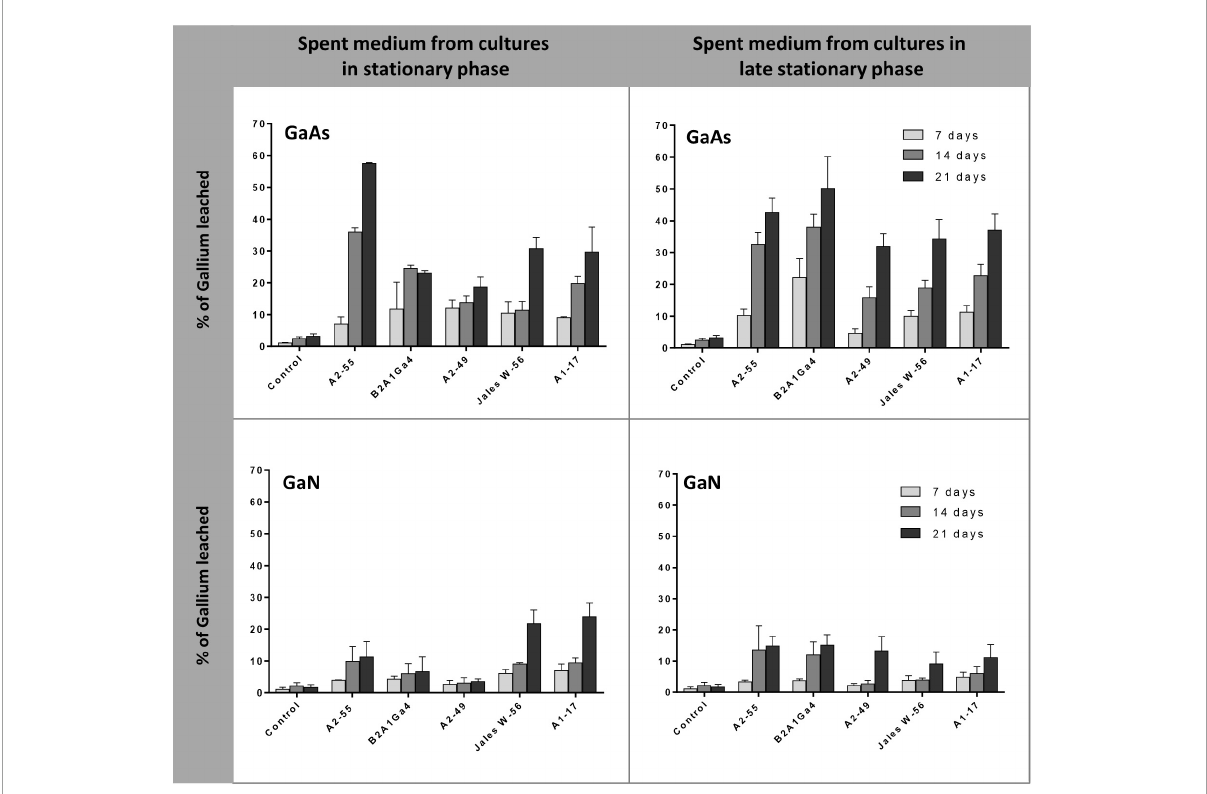
FIGURE5 Gallium leaching from GaAs and GaN by cell-free spent medium of cultures at different phases (stationary, 24 h, and late stationary, 48 h). Strains: Arthrobacter silviterrae A2-55, Rhodanobacter sp. B2A1Ga4, Sphingomonas sp. A2-49, Undibacterium sp. Jales W-56, and Rugamonas sp. A1-17. Ga in leaching medium was determined at day 7, 14, and 21 of the experiments. Data are the mean values ( ± standard deviations) obtained from two or three independent